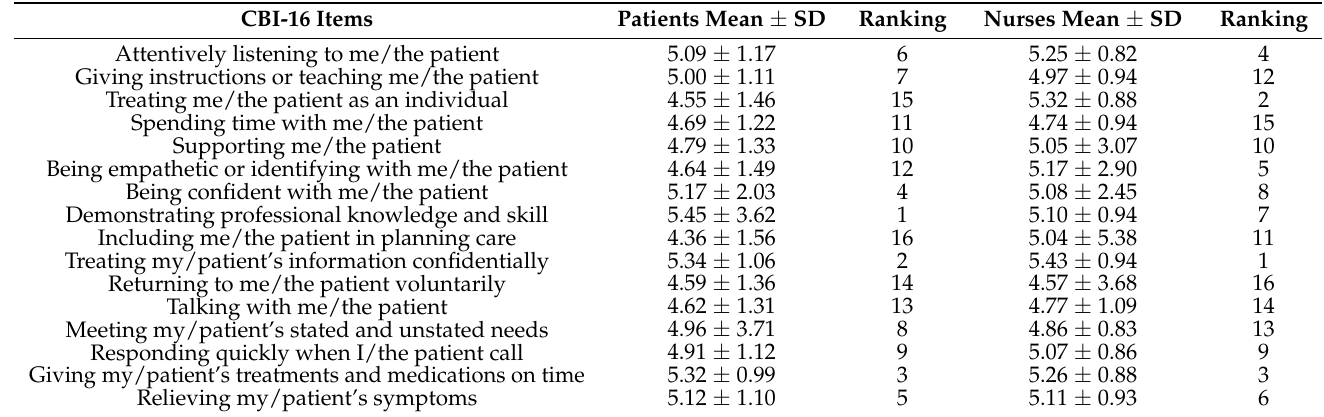
Table 3. Mean scores and ranking of CBI-16 items between the patients’ and nurses’ groups. CBI-16